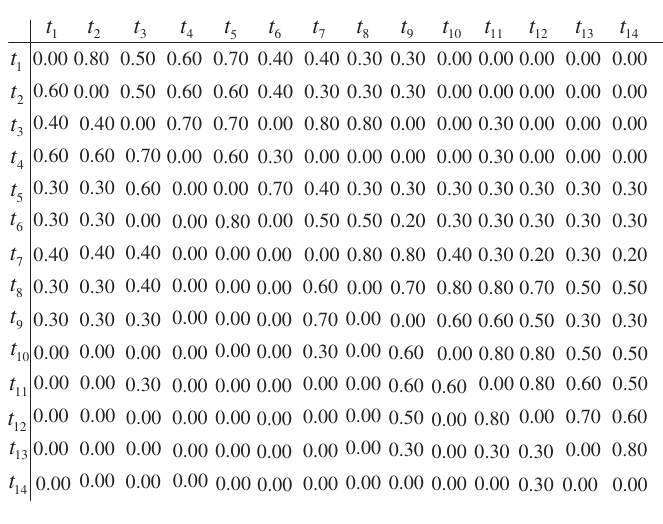
Figure 6: The Influence Relationship Among Tasks.